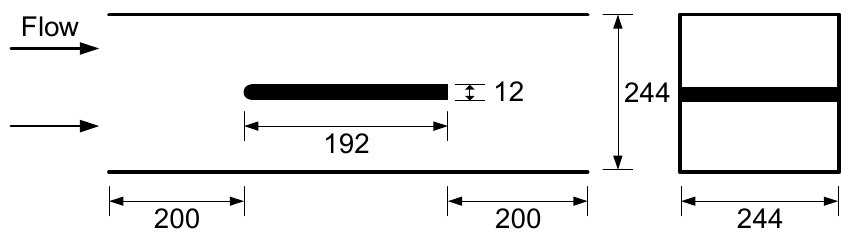
Figure 8. Diagram of calculation model.